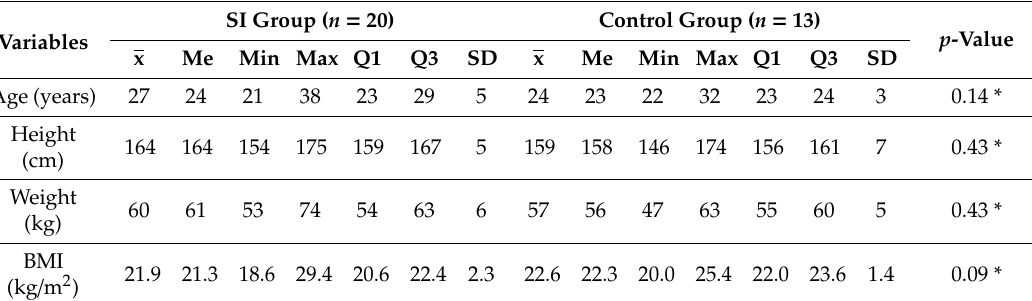
Figure 1. The CONSORT 2010 flow chart of participants in the study. Table 3. Participants’ characteristics in the experimental (SI) and control groups.